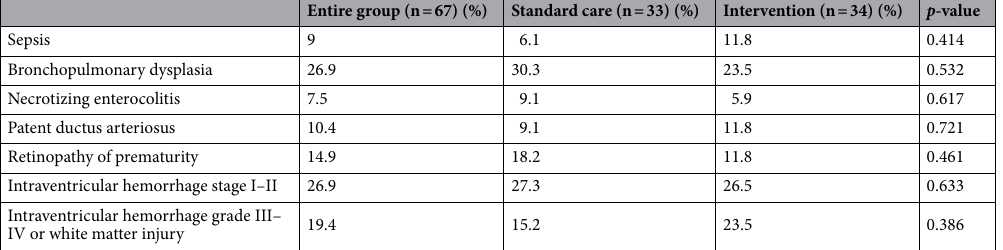
Table 2. Neurological and medical comorbidities of groups.